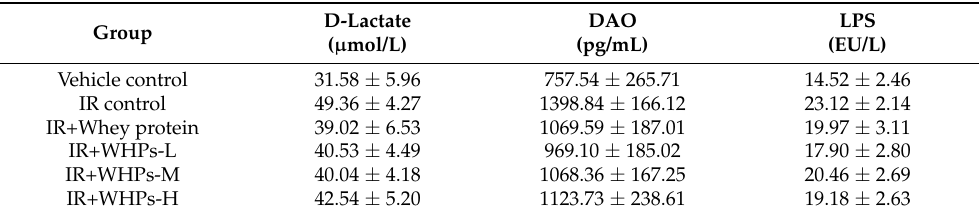
Table 11. Effect of WHPs on intestinal permeability in irradiated mice on third day ( n = 12, x ± s).